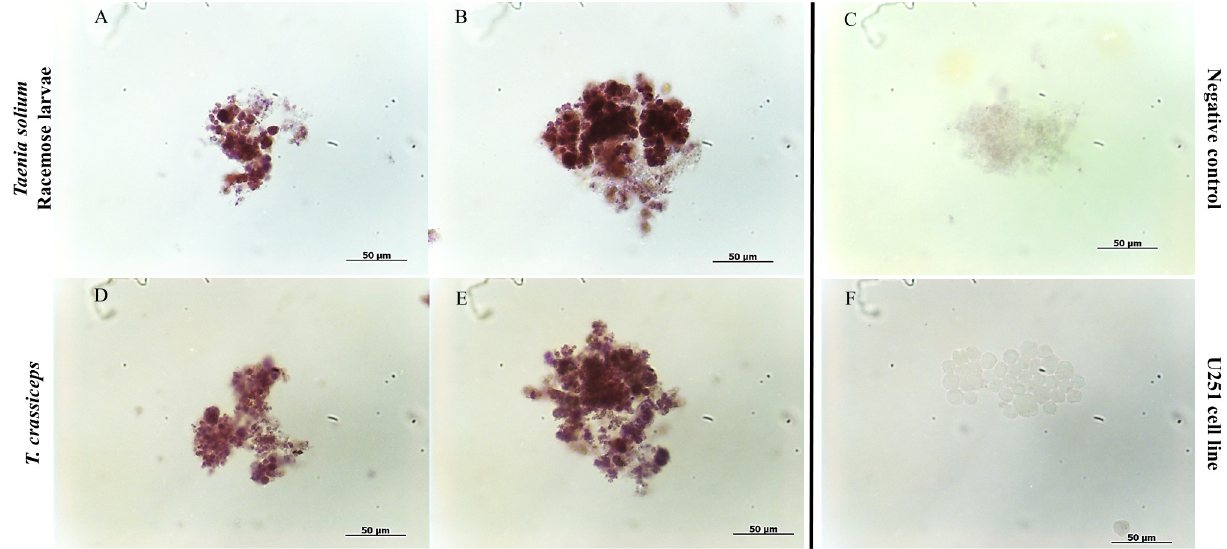
Fig 10. ISH assay in proliferative cells isolated from T . solium larvae and T . crassiceps cyst. The cells express plk1 before (A,D) and after being cultured 1 week with insulin (B,E). A sense probe (C) was used as a negative control. The human glioblastoma cell line U251 (F) was used as a control for specificity.